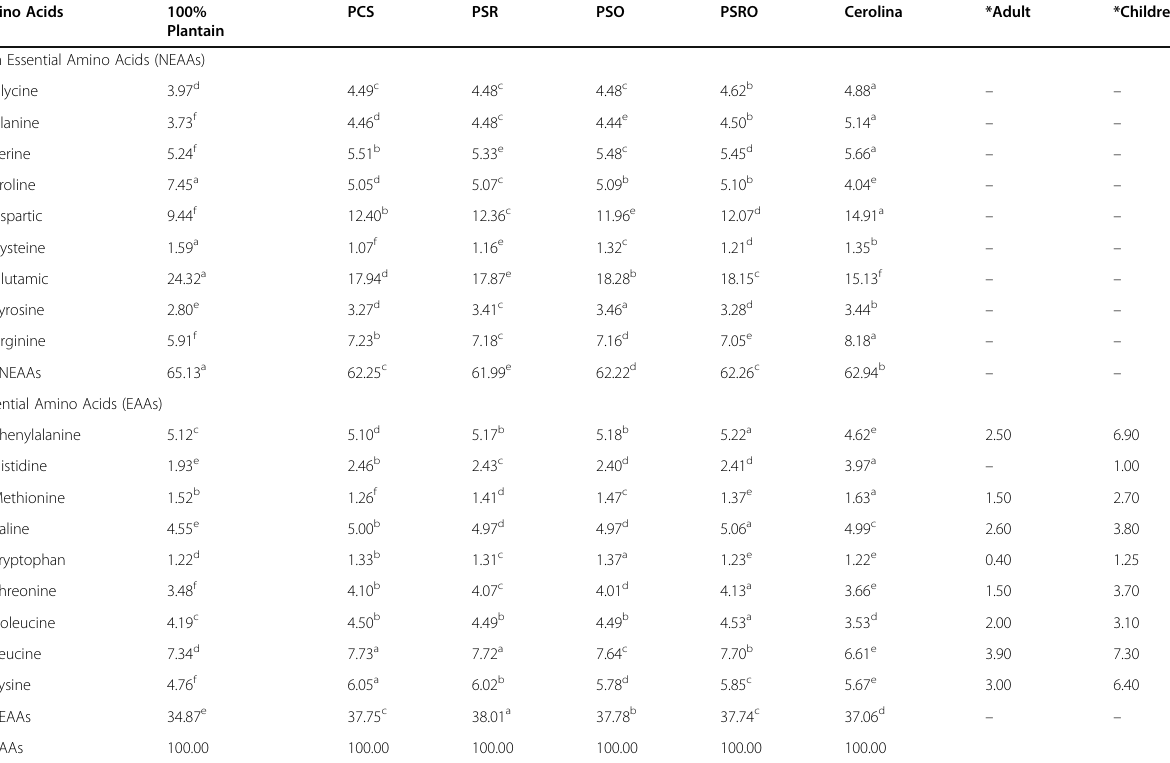
Table 2 Amino acid profile (g/100 g protein) of plantain, soycake, rice bran and oat bran flour and control sample Amino Acids 100% PCS PSR PSO PSRO Cerolina *Adult *Children Plantain Non Essential Amino Acids (NEAAs) Glycine